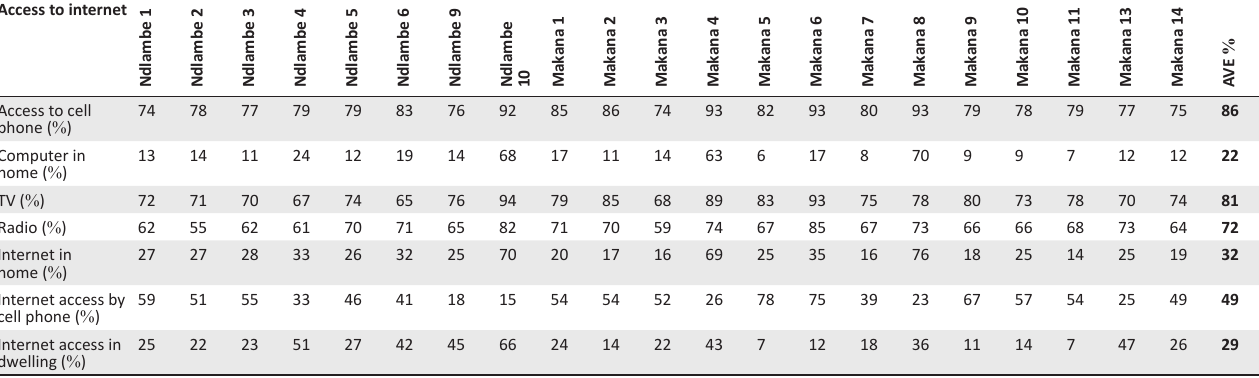
TABLE 2: Access to internet and other modalities for learning support in target communities. Access to